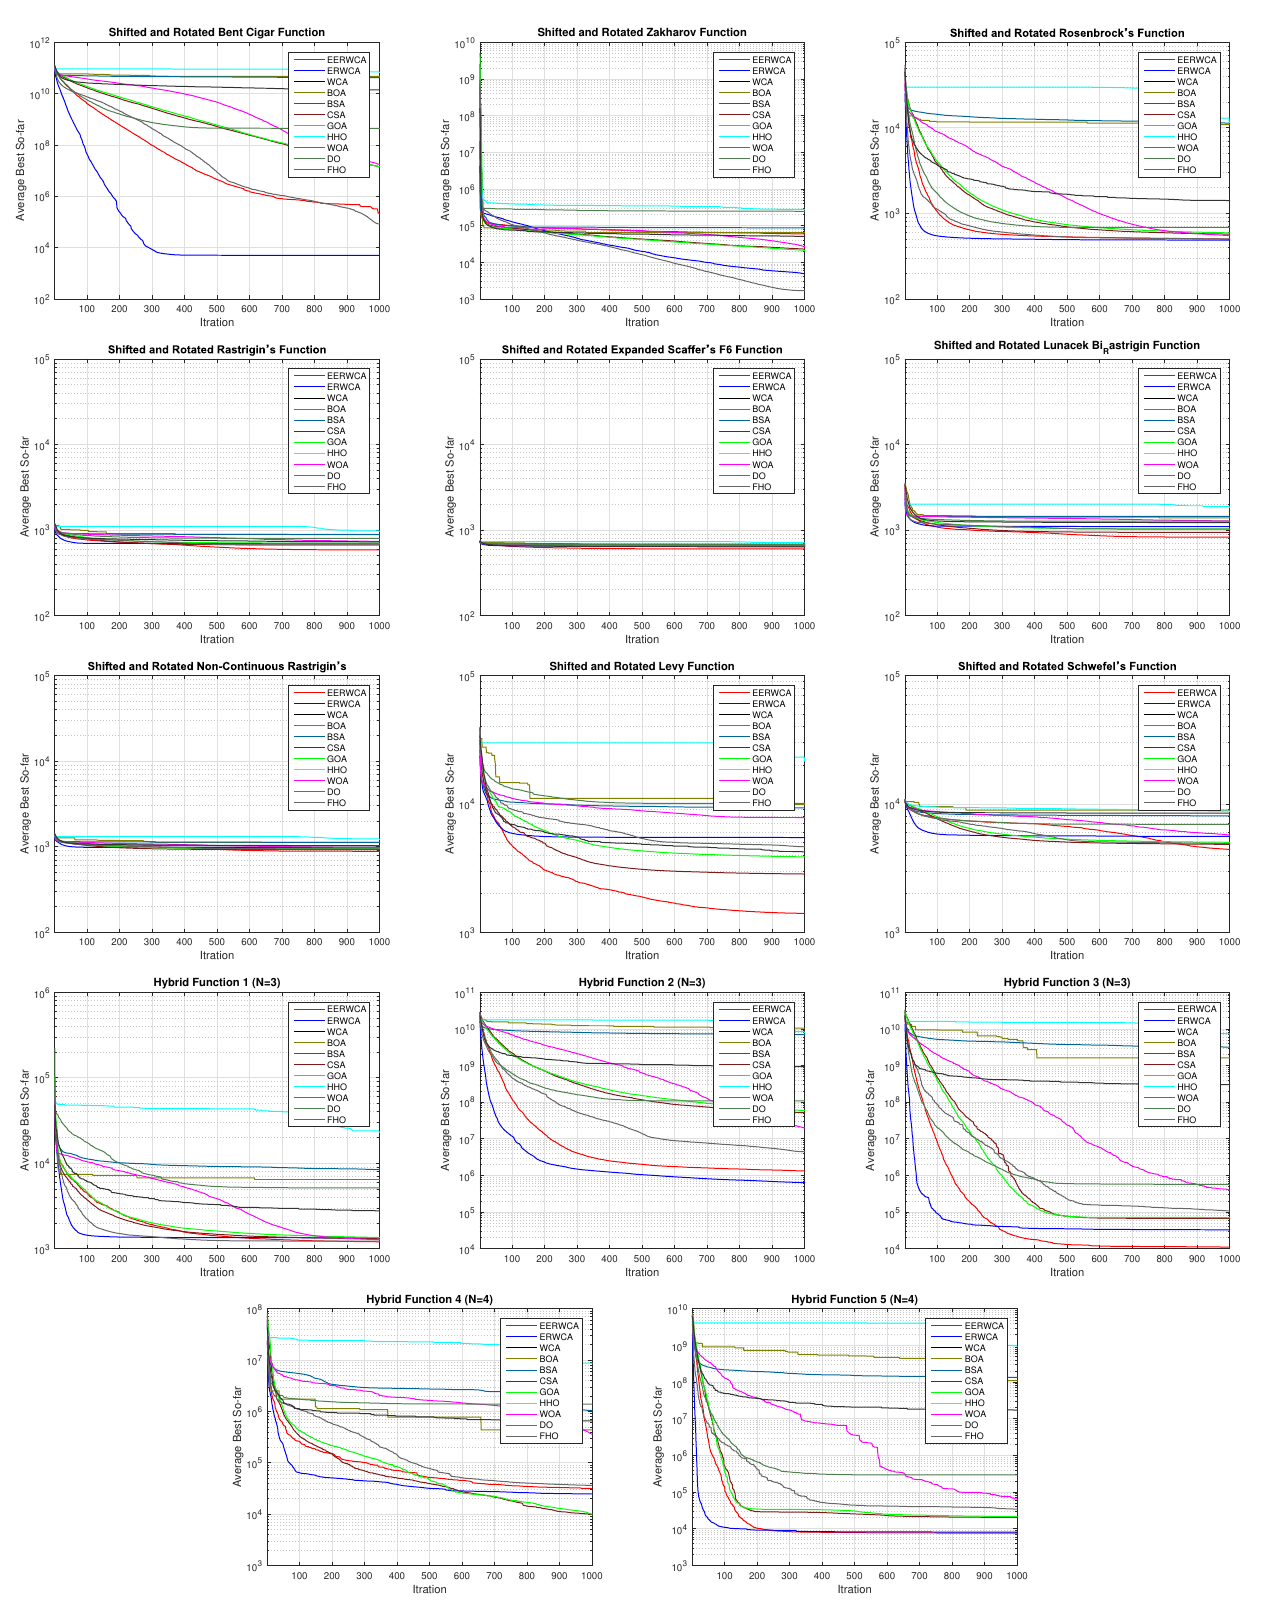
Figure 2. Convergence curve of some functions from F1–F15 for all algorithms using CEC2017 and dim =